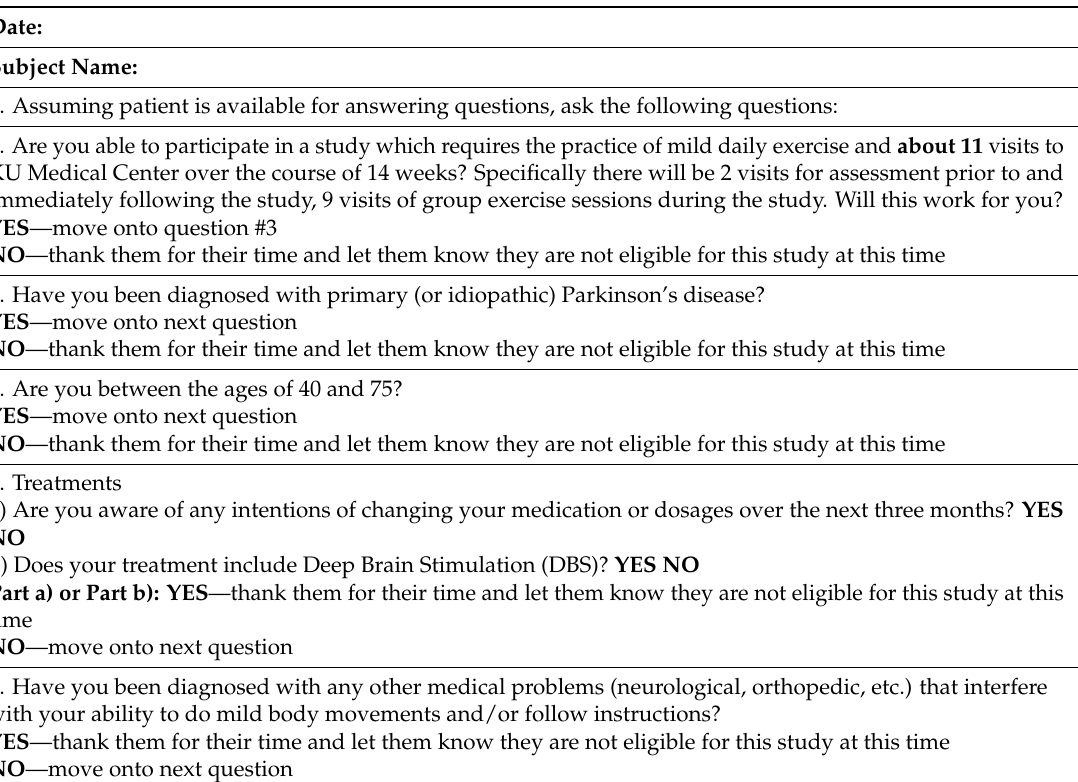
Table A1. Phone screening